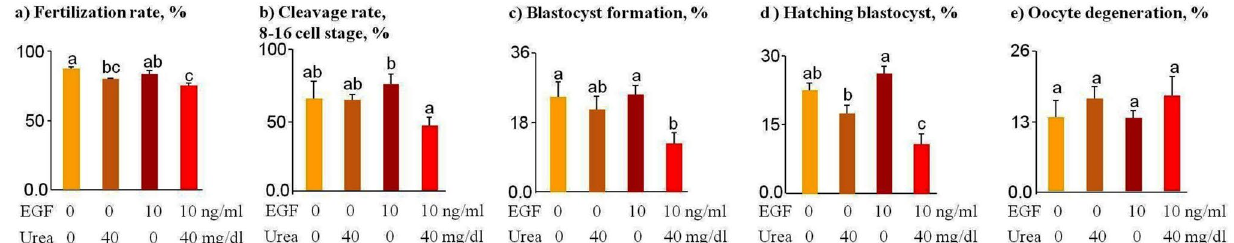
Figure 4. The result of in vitro fertilization in response to sperm pre-incubated with EGF or urea. Bovine sperm cells were pre-incubated with urea (40 mg/dl) for 30 min in the presence or absence of EGF (10 ng/ ml). Data was obtained with a total of six replicates (n = 6, 28–36 embryos per replication) and analyzed using the Tukey test. Numerical values are presented as mean ± S.E.M. Different letters (a, b, c) indicate significant differences between treatments at P < 0.05.